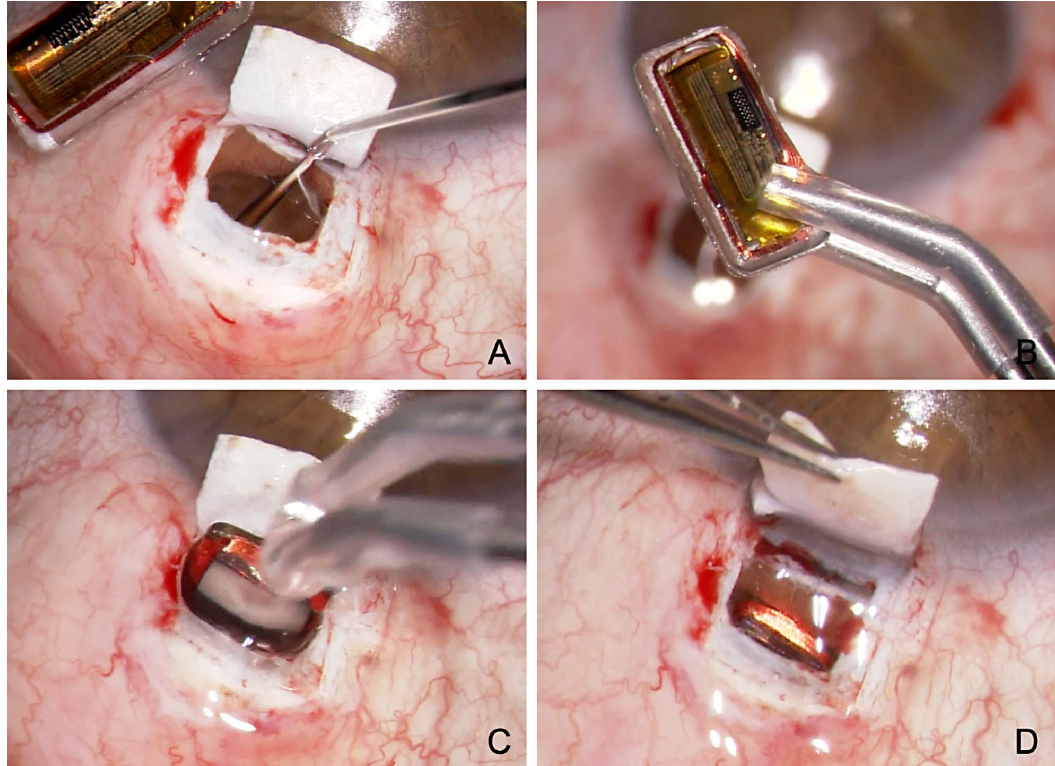
Figure 7. Surgical technique of suprachoroidal implantation of the Eyemate-SC sensor. ( A ) Viscoelastic is injected at the end of the CP with ScD to expand the suprachoroidal space ( B ) The Eyemate-SC sensor is grasped carefully with padded implantation forceps. ( C ) The sensor is implanted into the suprachoroidal space. ( D ) The Eyemate-SC sensor serves as a placeholder for suprachoroidal drainage while allowing continuous IOP monitoring.